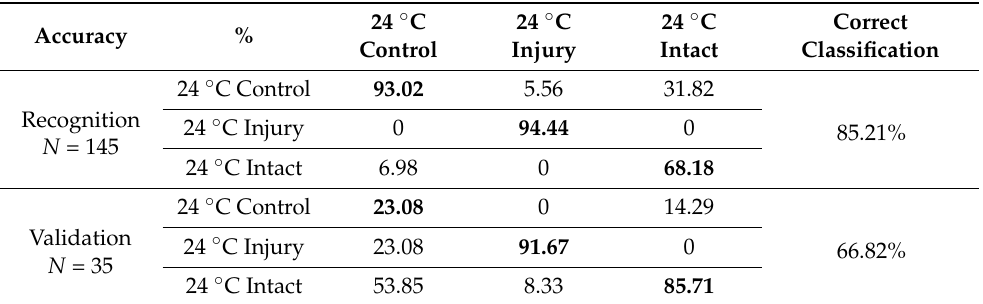
Table 4. PCA-LDA classification model on the NIRS data of control and infected plums stored at 24 ◦ C with 4th parallel sample data validation when the inoculation mode was used as class variable ( N = 180, and NrPCs = 10).